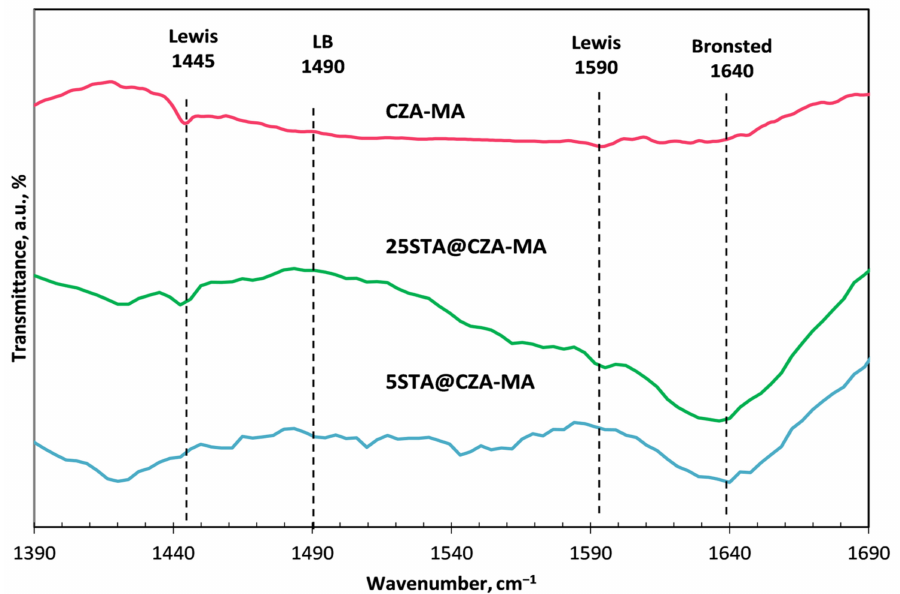
Figure 5. DRIFT spectra of the STA incorporated core-shell catalysts.